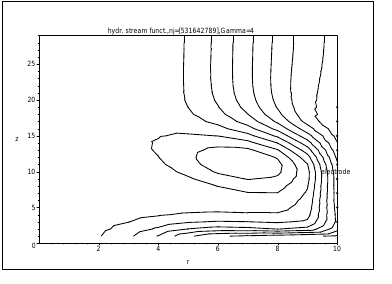
Figure 7. The stream functions for nj = [761835924] , ψ ∈ (0 . 00 , 0 . 17) , Γ = 0 .